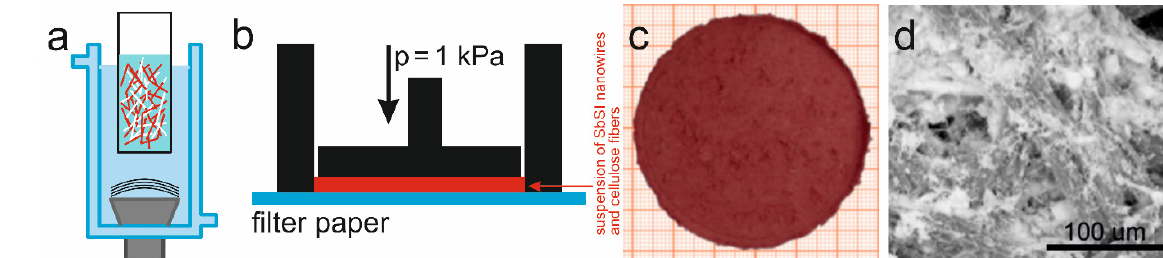
Figure 4. Schematic diagram for the fabrication of a cellulose/SbSI composite. ( a ) Ultrasonic mixing of the SbSI nanowires and cellulose fibers in water. ( b ) Drying of the homogeneous suspension that contains the SbSI nanowires and cellulose fibers, under a pressure of 1kPa. ( c ) Photograph and ( d ) SEM image of the obtained sheet of cellulose/SbSI nanocomposite.